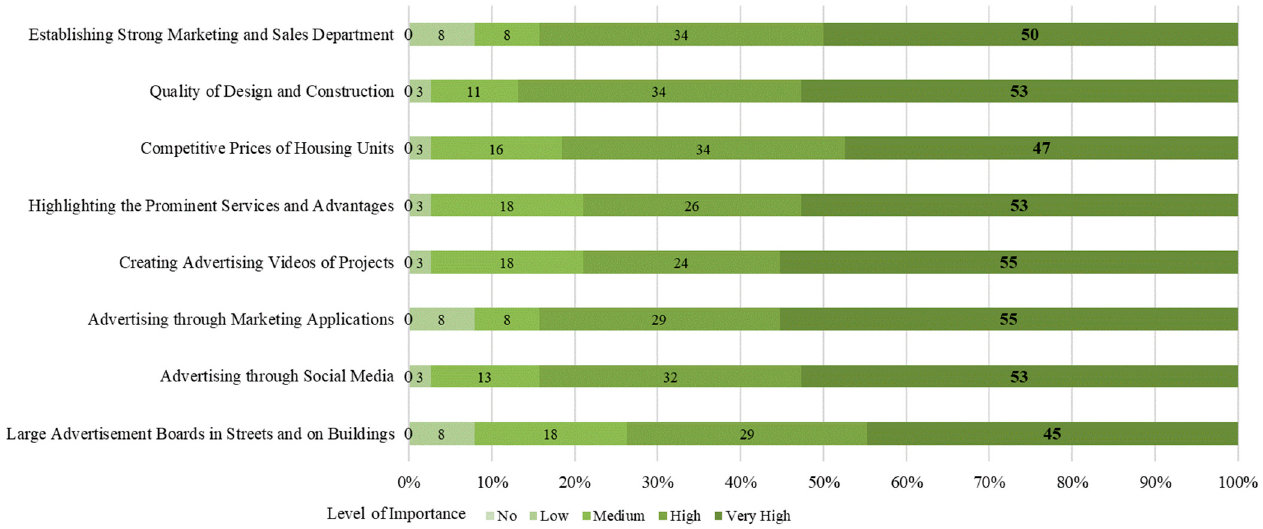
Figure 11. Response Percentage for each Proposed Marketing Measure.